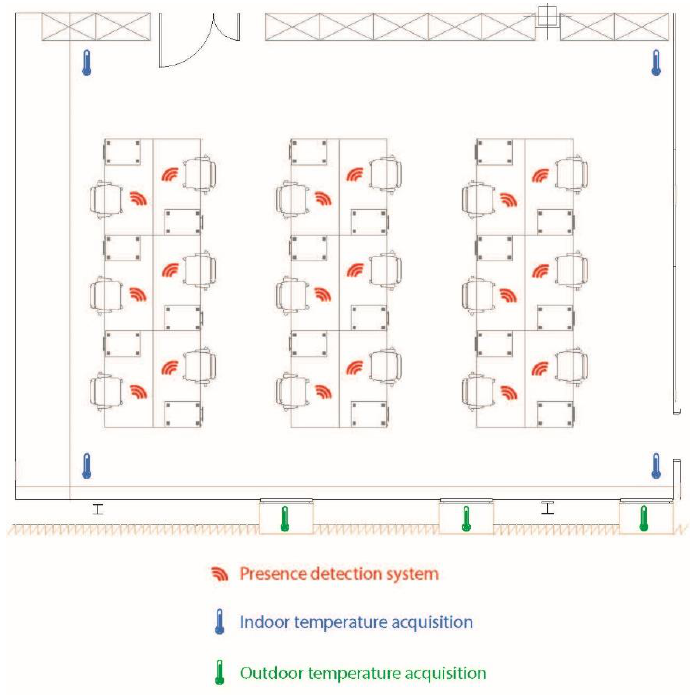
Figure 9. Example of the display of sensors in office 4.